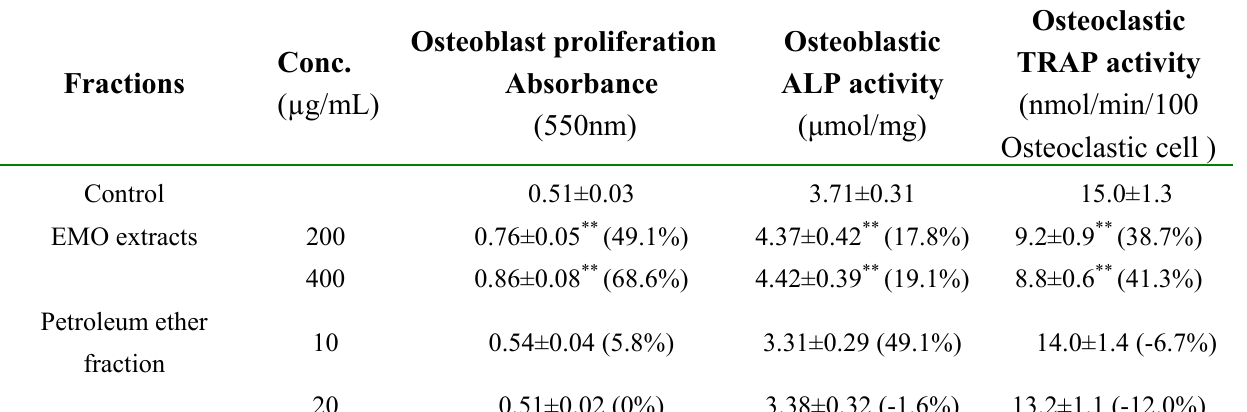
Table 1. Effects of various fractions of ethanolic extracts of Morinda officinalis (EMO) on osteoblast and osteoclast (n=8,